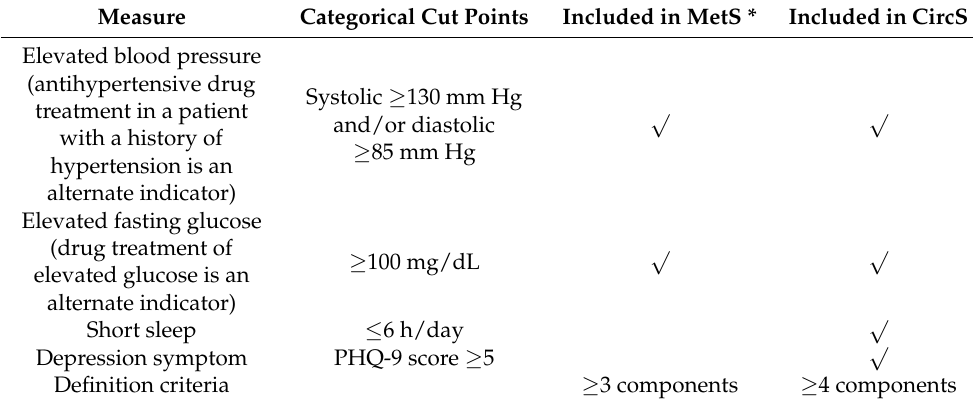
Table 1. Cont. Measure Categorical Cut Points Included in MetS * Included in CircS Elevated blood pressure (antihypertensive drug treatment in a